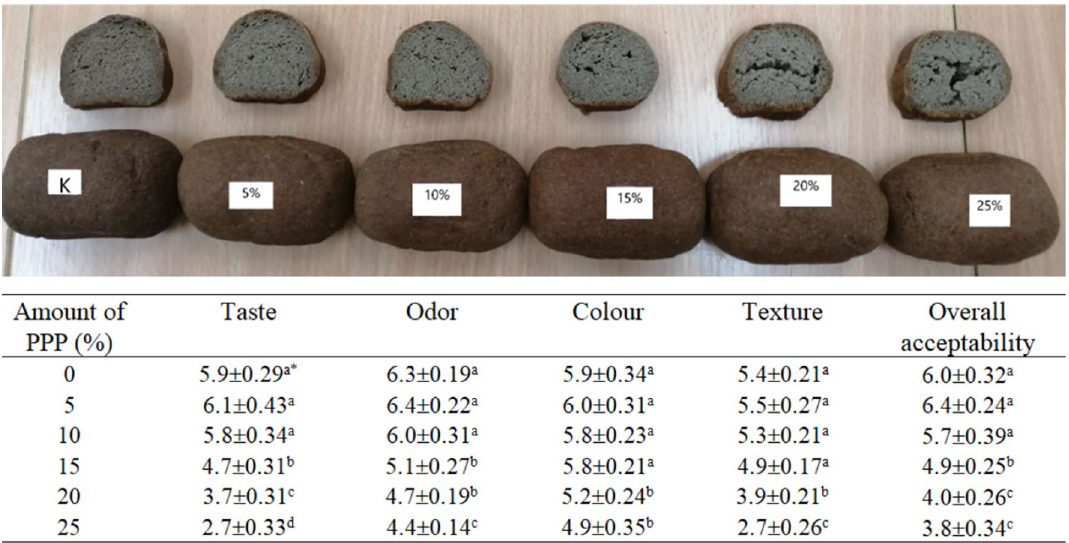
PPP addition was characterized by lower hardness after 48 h of storage compared to the sample stored for 24 h (decrease of about 2 N). However, in general, a higher share of the PPP brought about an increase in the bread crumb hardness, and chewiness, and a decrease in cohesivness. In contrast, the springiness of bread crumb (Fig. 2c) increased already with small amounts of PPP addition, as compared to control bread. Sensory evaluation of low‑carbohydrate bread with pea protein. The results of the sensory evalu- ation of the low-carbohydrate bread enriched with pea protein powder are presented in Fig. 3.Sensory evaluation showed that the control bread, and the bread with PPP addition at the levels of 5, and 10% had the highest liking score. Similarly, Ziobro et al . 41 demonstrated in the sensory evaluation of gluten-free bread with the addition of non-gluten proteins (i.e. albumin, soy, pea, lupine, collagen) that the bread supplemented with pea protein was the best assessed in case of structure, and porosity, and obtained the highest number of points for taste, and smell among the evaluated bread. The addition of higher levels of PPP (above 15%) caused an unpleasant aroma, and bitter taste. Furthermore, the low-carbohydrate bread generally received slightly low notes for the texture. It was caused by higher water addition, and the lack of gluten in the composition of flours used in the production of bread. It was also found that a higher percentage of pea protein caused crumbling of the crumb, and generally, the texture was not compact. The addition of PPP did not significantly change the bread crumb colour, which had a dark-brown colour that was generally acceptable for the evaluators. Amino‑acid and fatty acid composition of low carbohydrate bread with optimal pea pro‑ tein. Supplementation of low-carbohydrate bread with 10% of pea protein increased the content of all ana- lyzed amino acids (Table 2). The chemical score (CS) for each essential amino acid has increased. The lowest value of CS was observed for leucine. EAAI value increased from 34 to 40 after the addition of the optimal protein supplement (10% PPP). According to Gorissen et al . 42 pea as a plant-based protein source is rich in essential amino acids like lysine, and leucine, and non-essential amino acids like arginine, alanine, proline, and glutamic acid. The authors pointed out that pea has essential amino acid contents that meet the requirements as recommended by the WHO/FAO/ UNU, and that the amount of essential amino acid in pea is higher than in plant materials, such as corn, soy, hemp, lupine, oat or brown rice. In the case of the content of glycine, cysteic acid, methionine sulfone, and his- tidine, only a slight increase in their content was detected in the composition of bread with 10% PPP addition, which was not statistically significant. In the analyzed bread the following fatty acids were identified above 0.100 g/100 g: palmitic acid, octadecanoic acid, oleic acid + elaidic acid, linoleic acid + trans-9,12-octadecadienoic acid, and α-linolenic acid (Table 3). A significant increase of α-linolenic acid content in relation to the control bread occurred in the bread with 10% pea protein. Caloric value of low‑carbohydrate bread with optimal pea protein amount. The addition of PPP had a significant effect on the chemical composition of the low-carbohydrate bread (Table 2). In the case of the bread with the optimum amount of pea protein at the level of 10% significant increases in the protein content (from 14.7% to 17.1%), and decrease in the carbohydrates content (from 18.4% to 16.9%) was noticed. Accord- ing to García-Segovia 43 the addition of 10% of pea protein increased protein content (to 19.3%), compared with